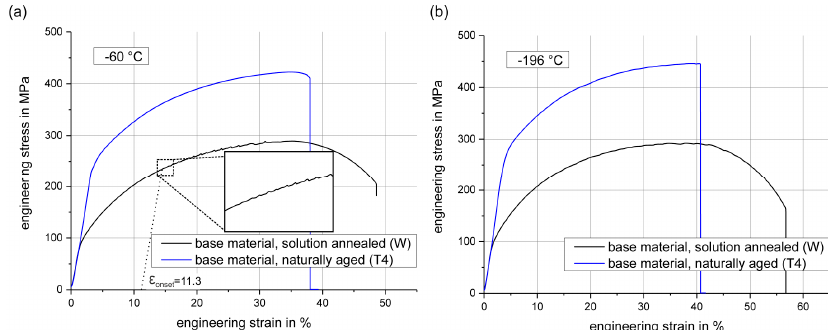
Figure 6. Tensile engineering stress-strain curves measured at low temperatures. ( a ) AA2017 base material in solution annealed condition W and in naturally aged condition T4 at − 60 °C. ( b ) AA2017 base material in solution annealed condition W and in naturally aged condition T4 at − 196 °C. Only the W-conditions still exhibit a slightly serrated flow associated with the PLC effect (inset at higher magnification). The serrations decrease with decreasing testing temperature.